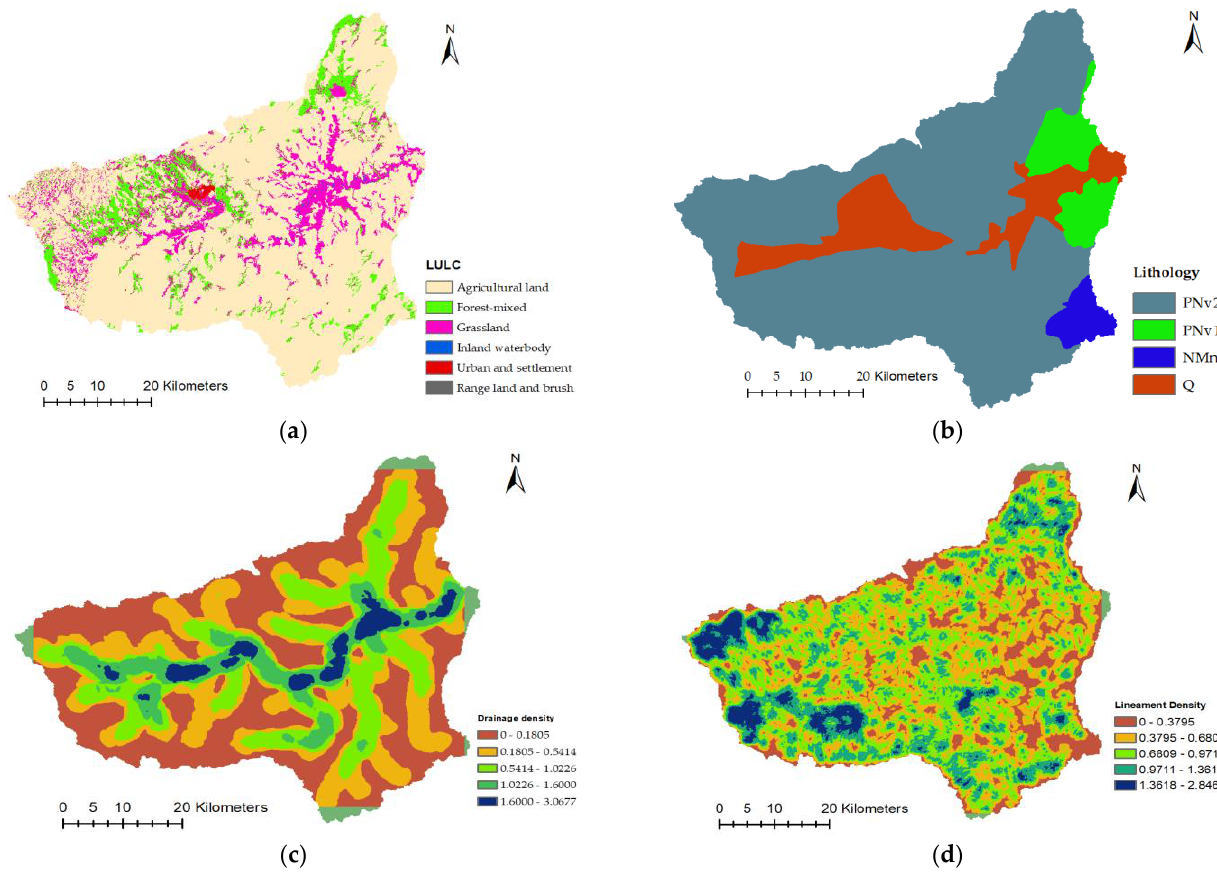
Figure 4. Thematic map of ( a ) LULC, ( b ) Lithology, ( c ) Drainage density, ( d ) Lineament